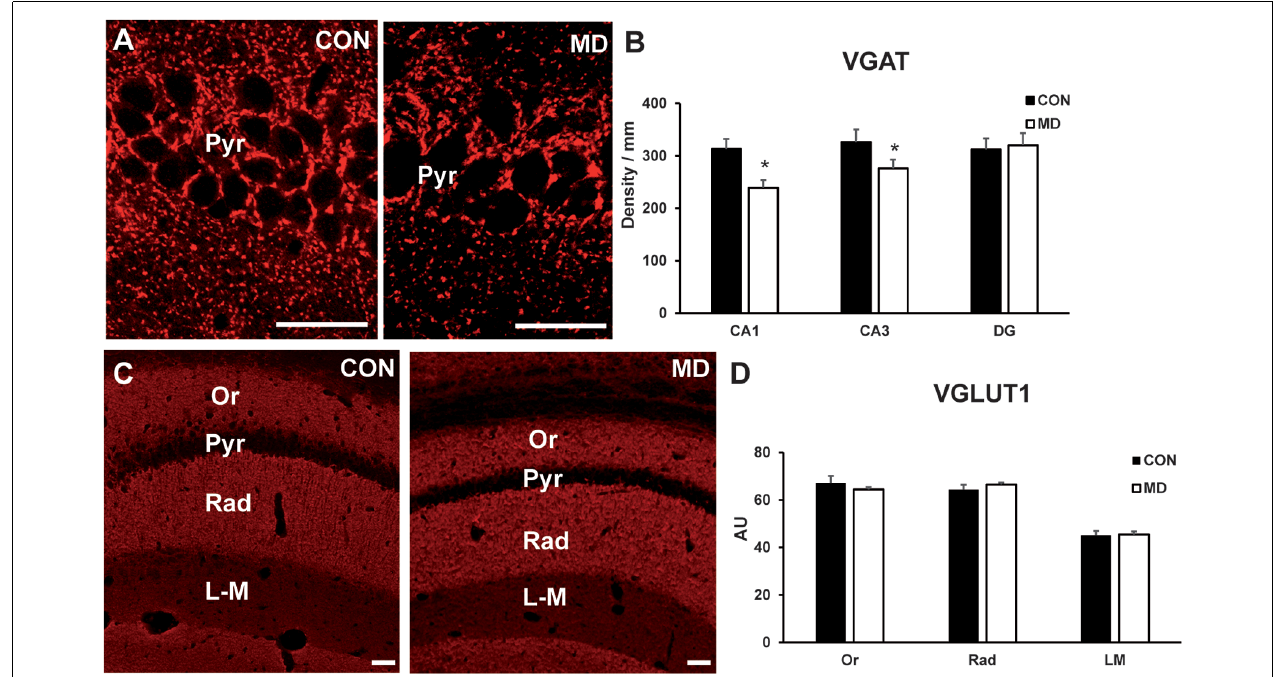
FIGURE 6 | Inhibitory and excitatory synapses. (A) Representative image of immunofluorescence staining for VGAT in the CA1 region of the hippocampus of a control (CON, left panel) and maternally deprived (MD, right panel) rat at P60. (B) Shown are mean values + standard error of the mean (SEM) for linear densities (number of immunopositive puncta per unit length) of VGAT+ puncta in the pyramidal layers (Pyr) of the CA1 and CA3, and granular layer of dentate gyrus (DG) of MD and control rats (* p < 0.05, t -test, n = 6 animals per group). (C) Representative image of immunofluorescence staining for VGLUT1 in the hippocampus a control (CON, left panel) and maternally deprived (MD, right panel) rat at P60. (D) Shown are mean values + standard error of the mean (SEM) for mean fluorescence intensity of VGLUT1 in the stratum oriens (Or), radiatum (Rad) and lacunosum-moleculare (LM) of the CA1 hippocampal region of MD and CON rats ( p > 0.05, t -test, n = 6 animals per group). Scale bars: 50 µ